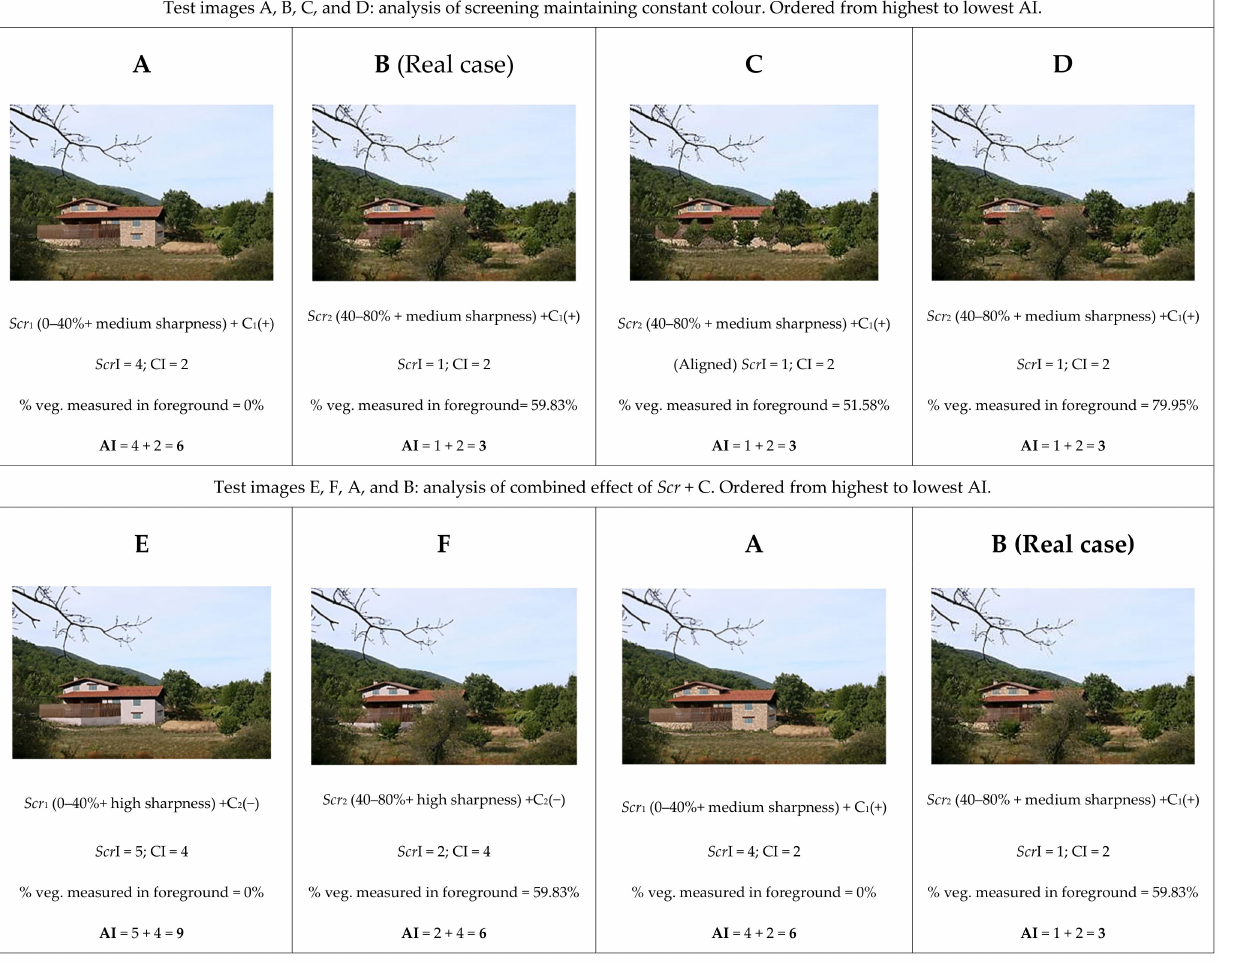
Figure 3. Survey images used with group 1 participants (residential buildings). Variable screening ( Scr ) shows two levels of change in the percentage of vegetation in front of the building (0–40% or 40–80%). The variable colour (C) presents two study proposals: (+) positive impact of building colour of less than 3 points; ( − ) negative impact of building colour of more than 3